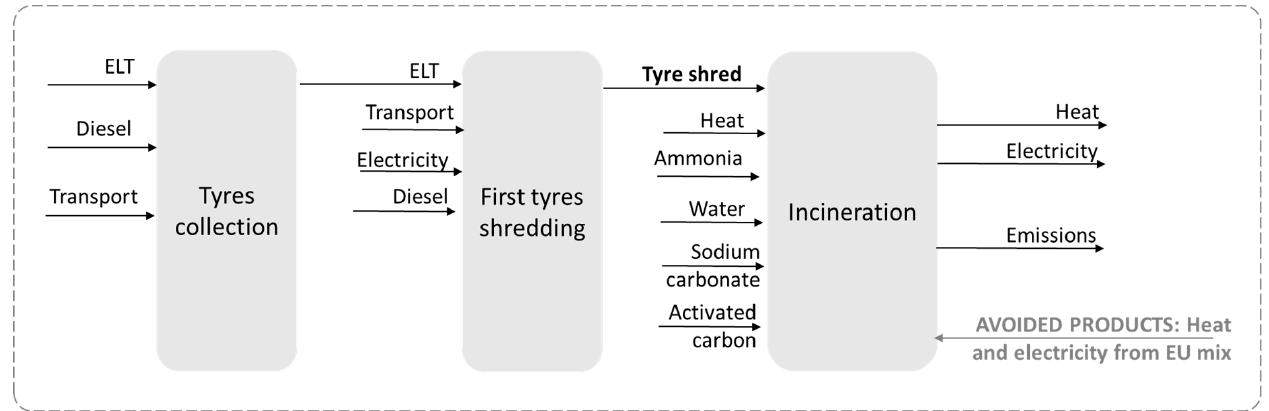
Figure 3. System boundaries of the energy recovery scenario.